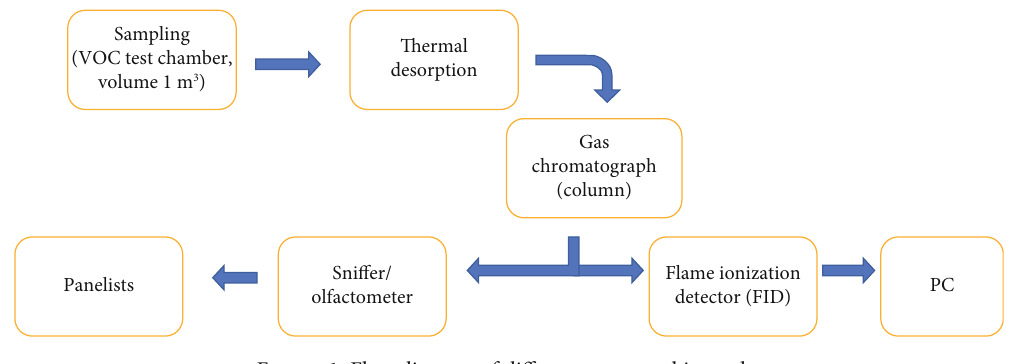
Figure 1: Flow diagram of di ff erent steps used in Table 3: Thermal desorption and GC-FID parameters used in the study (same GC used in part 1 of the study [15]).